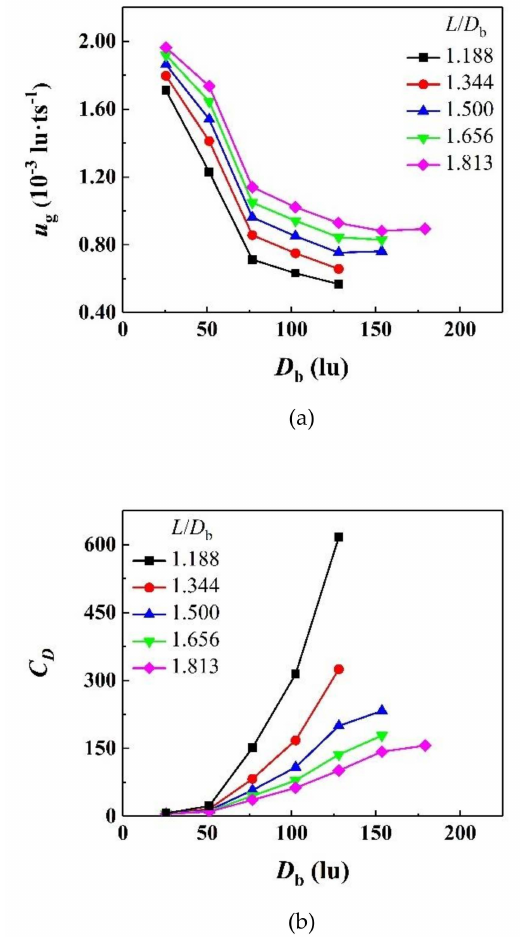
Figure 11. Variations of u g ( a ) and C D ( b ) with bubble diameter at Re Gr = 100 and Eo =